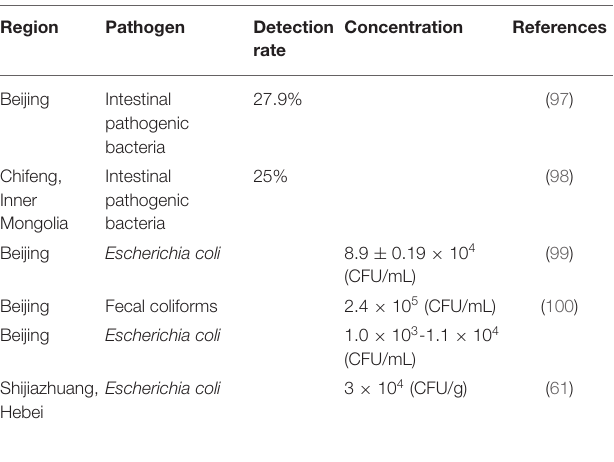
TABLE 6 | The experiment results on the impact of O 3 on crop yield.